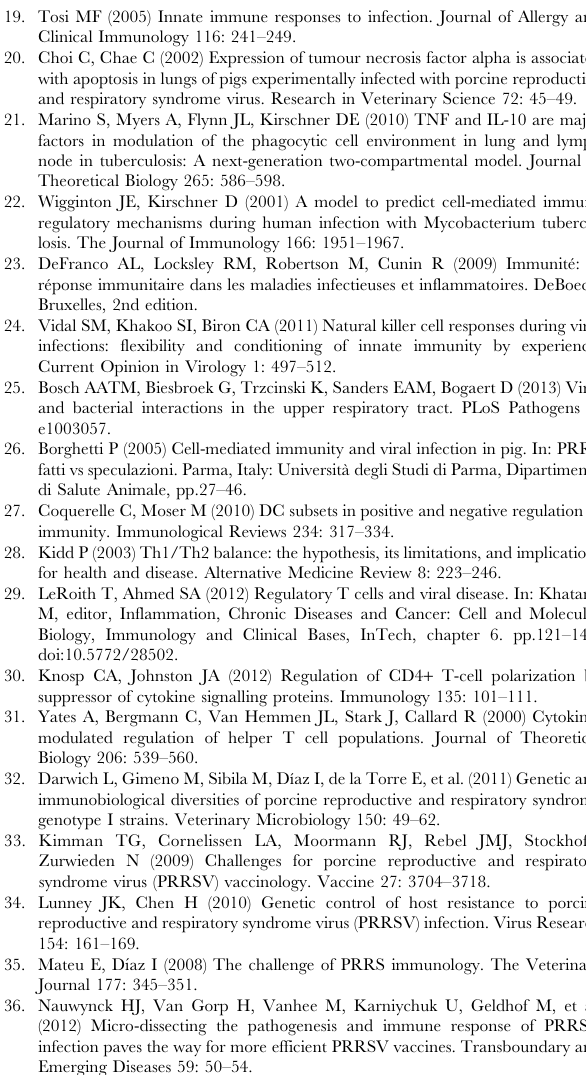
Figure S4 Parameter space exploration: percentage of infected macrophages. This figure results from the 6561 simulations performed for the sensitivity analysis. A : Percentage of infected macrophages among all macrophages ( % M I ) over time (red curve: reference scenario S0). B : Distribution of the % M I peak value. C : Distribution of the % M I peak date. The peak is defined as the maximum value of % M I over the course of infection. The % M I dynamics was highly variable